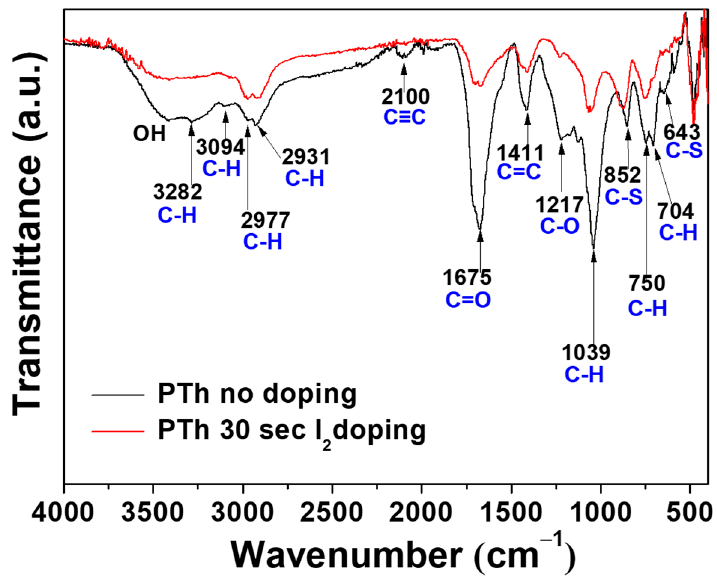
Figure 2. FT-IR spectra of the plasma polymerized thiophene films without and with I 2 doping.